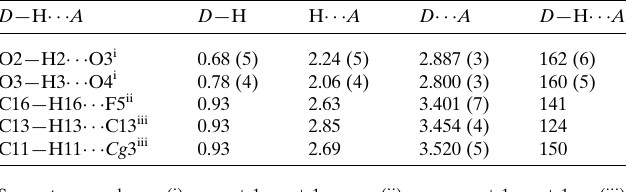
Table 1 Hydrogen-bond geometry (A˚ , (cid:3) ). Cg is the centroid of the C23–C27 ring.